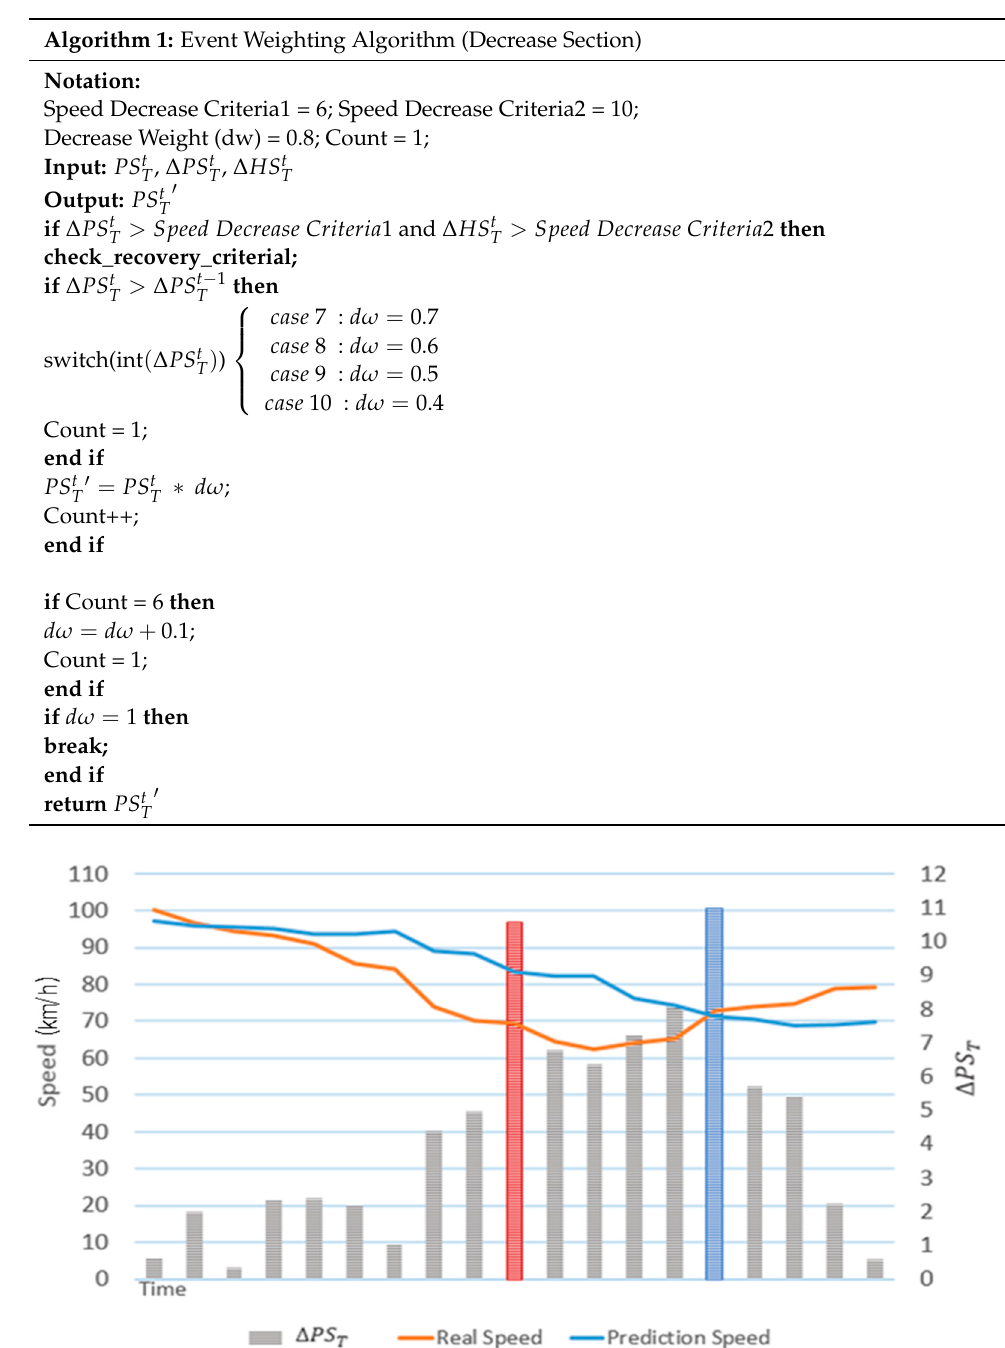
Algorithm 2: Event Weighting Algorithm (Recovery Section)